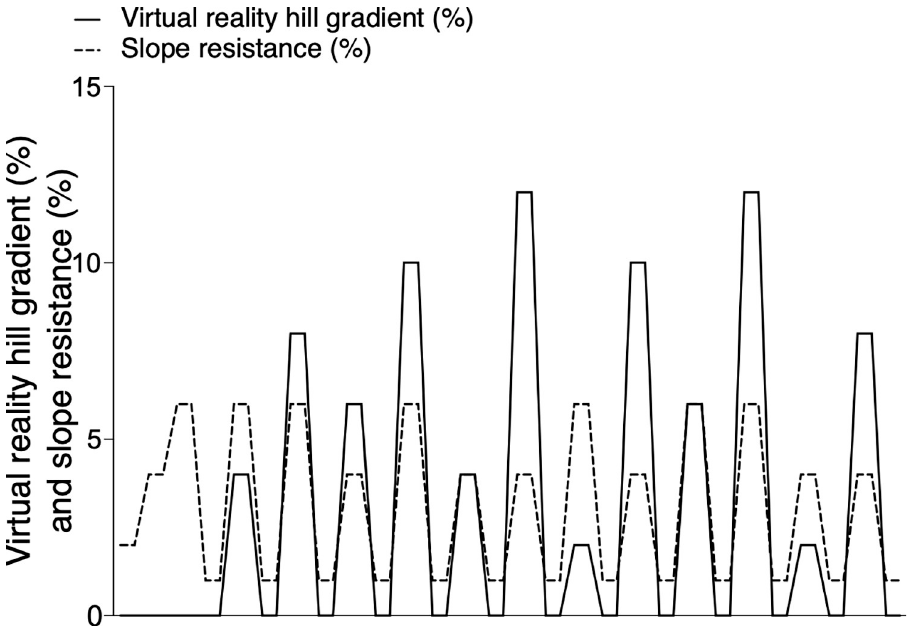
Fig 2. Illustration of exercise protocol where slope resistance (cycling ergometer resistance) was dissociated from the observed VR hill gradient.